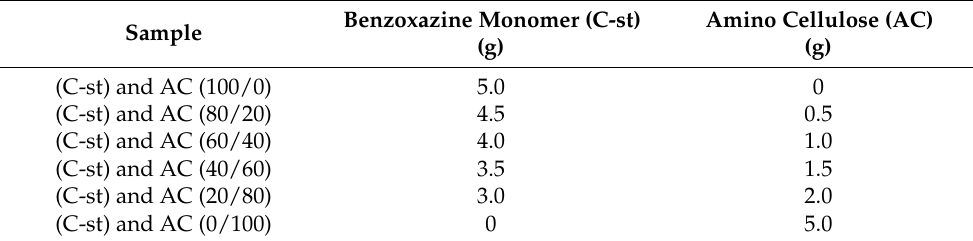
Table 1. Weight ratios of C-st and AC.